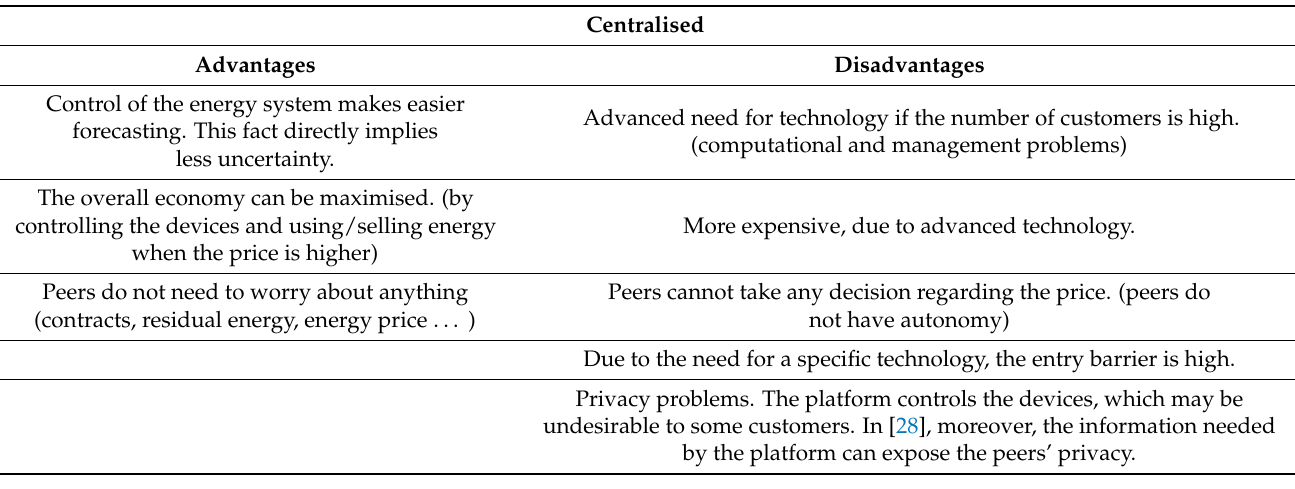
Table 3. Advantages and disadvantages—Centralised P2P-ET market. Table based on own interpre- tation from Section 2.2.1.